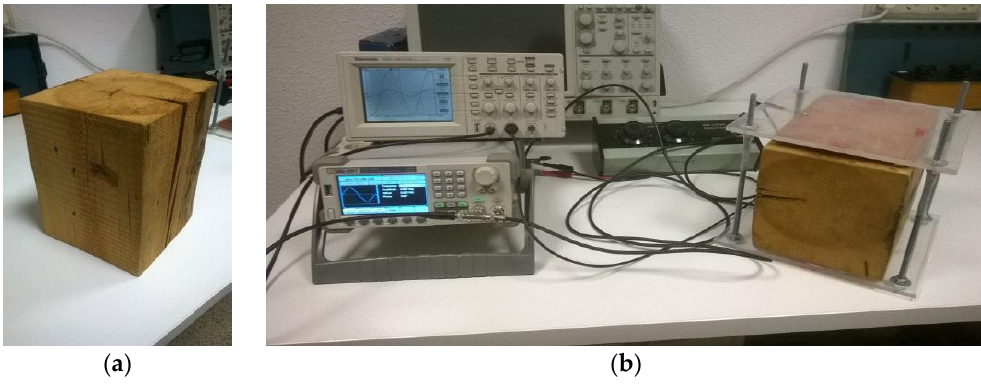
Figure 2. ( a ) Wood sample; ( b ) Measurement equipment with the wood sample.